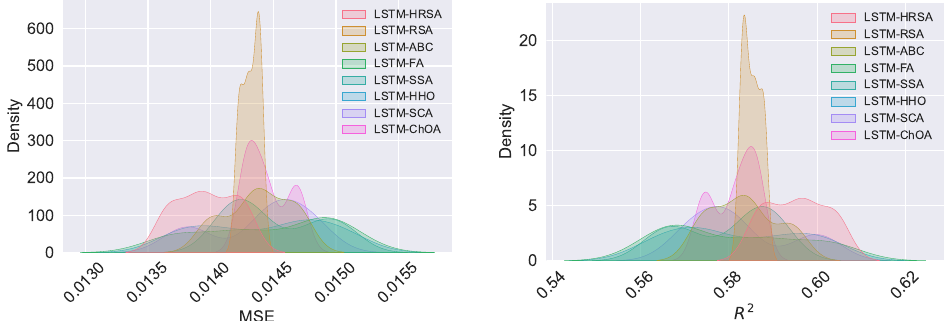
Figure 6. Graphical representation of the Kernel Distribution Estimation plots of LSTM in terms of fitness function (MSE) and